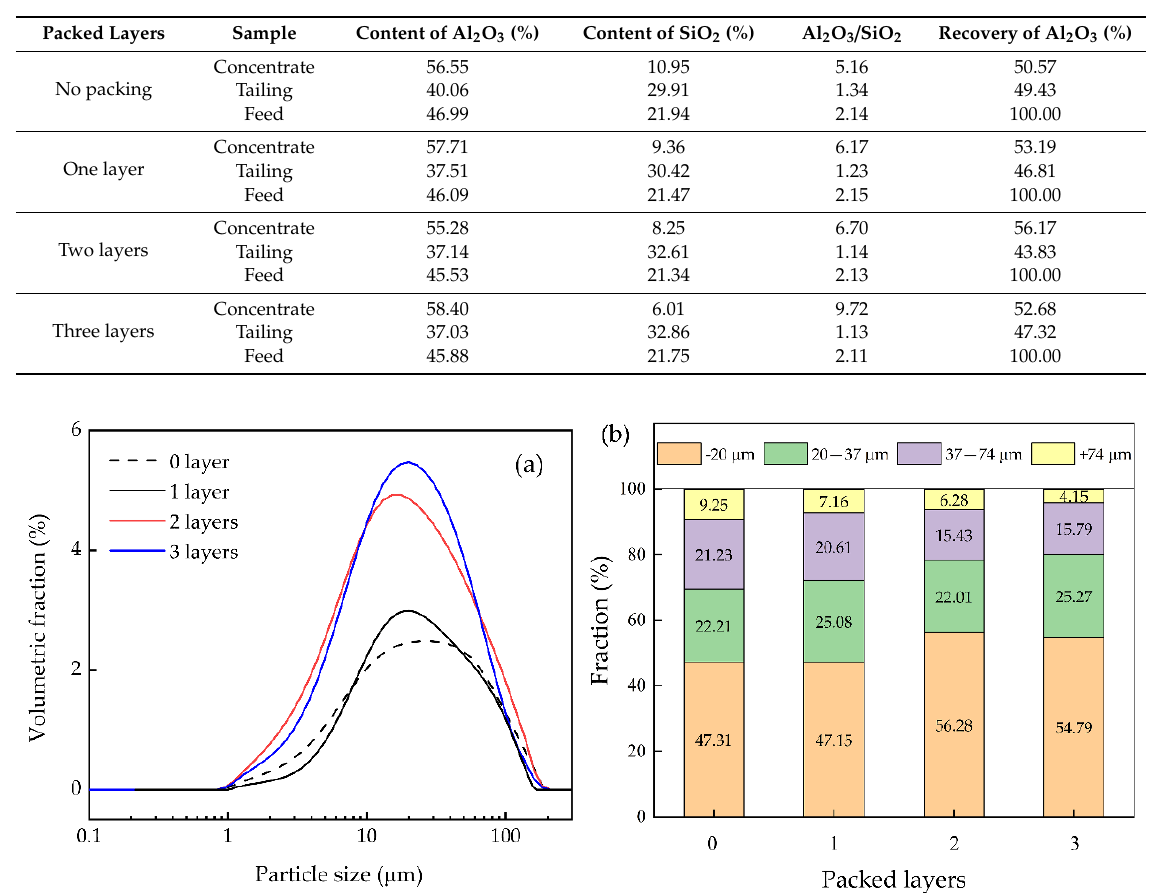
Table 3. Boundary conditions of simulation model.